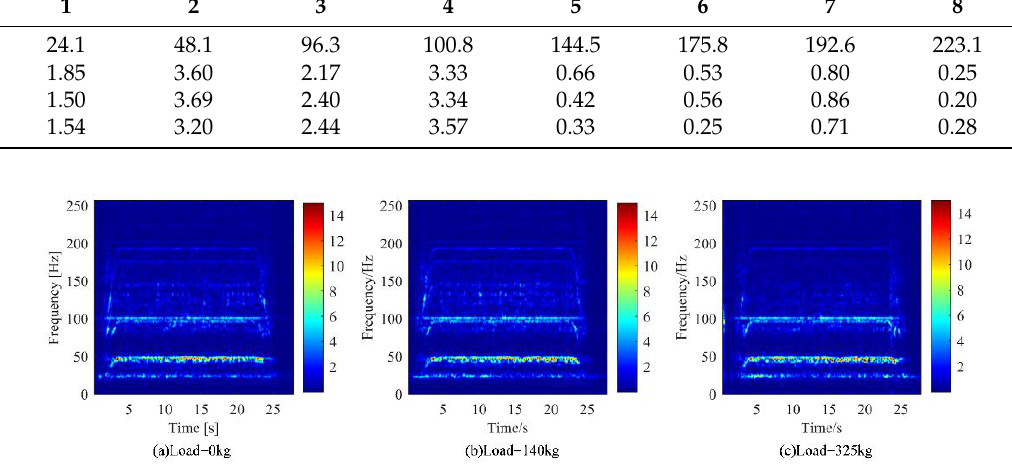
Figure 9. Vibration time-frequency diagram of down main machine under different loads of elevator. ( a ) Motor running under no-load condition. ( b ) Motor running under 140 kg load condition. ( c ) Motor running under 325 kg load condition. Table 5. Frequency domain peak value of vibration response of elevator with different loads.